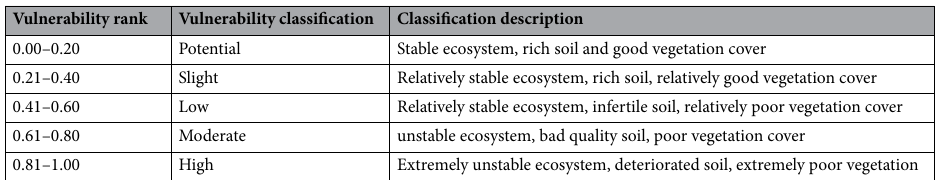
Table 4. References for classification. Note The scale 32,41 0–1 indicating the lowest EVI level (0) to the highest EVI level (1)is